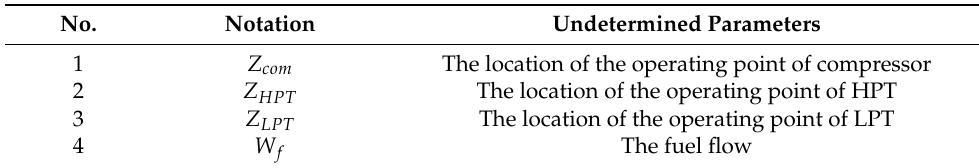
Table 1. The undetermined parameters in the simulation model. No. Notation